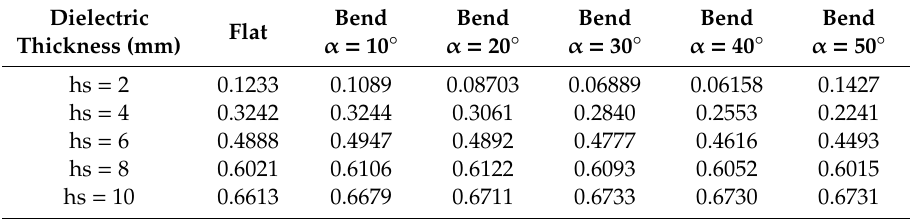
Table 3. Simulated antenna radiation pattern e ffi ciency for flat and bend positions at 2.45 GHz. Dielectric